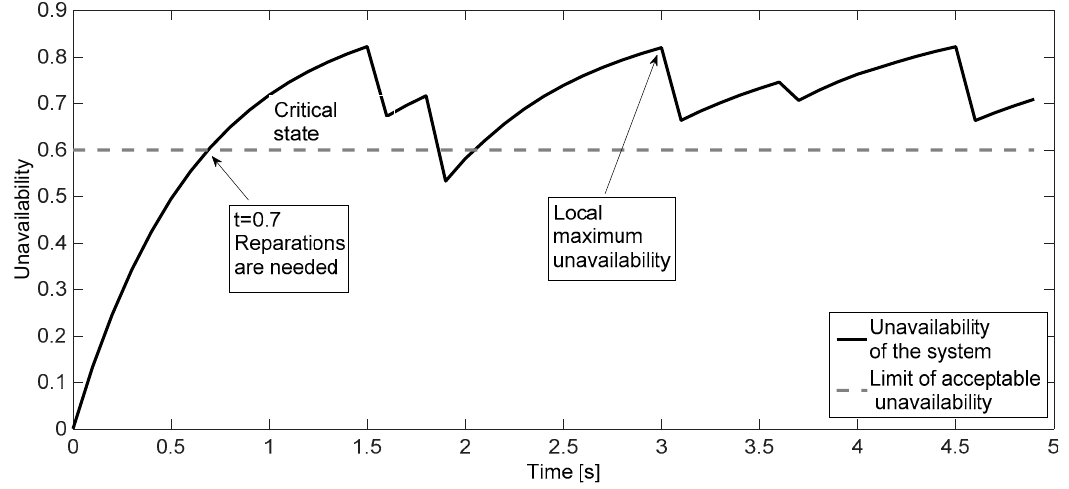
Figure 7. Unreliability threshold for a WT.